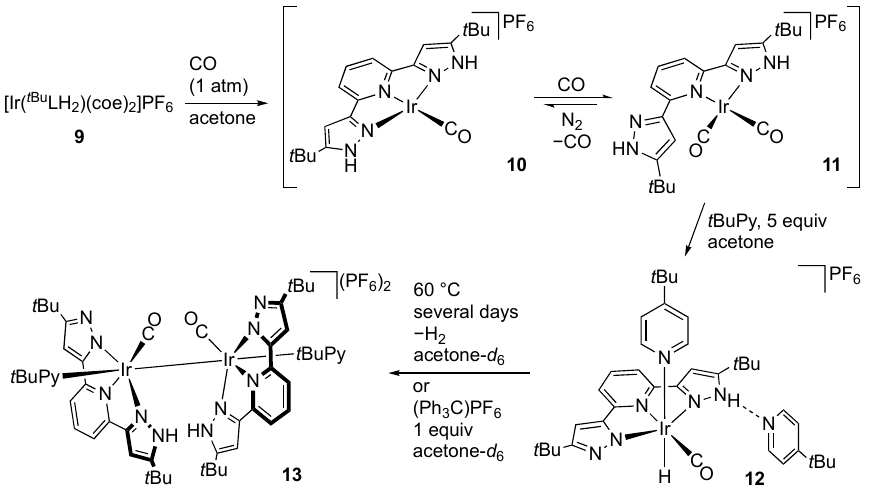
Scheme 5. Synthesis and reactions of t Bu LH 2 iridium complexes. coe = cyclooctene; t BuPy = 4- tert -